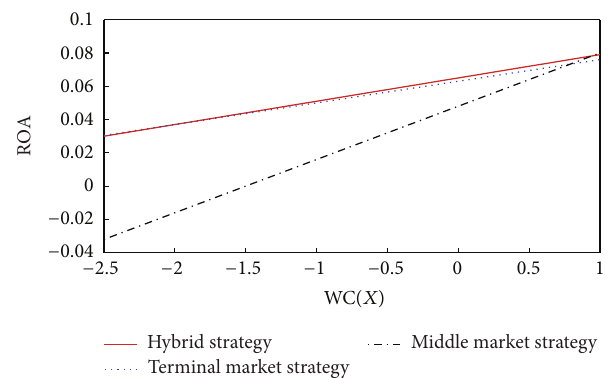
Figure 2: Marginal effects of working capital on performance in current strategies.